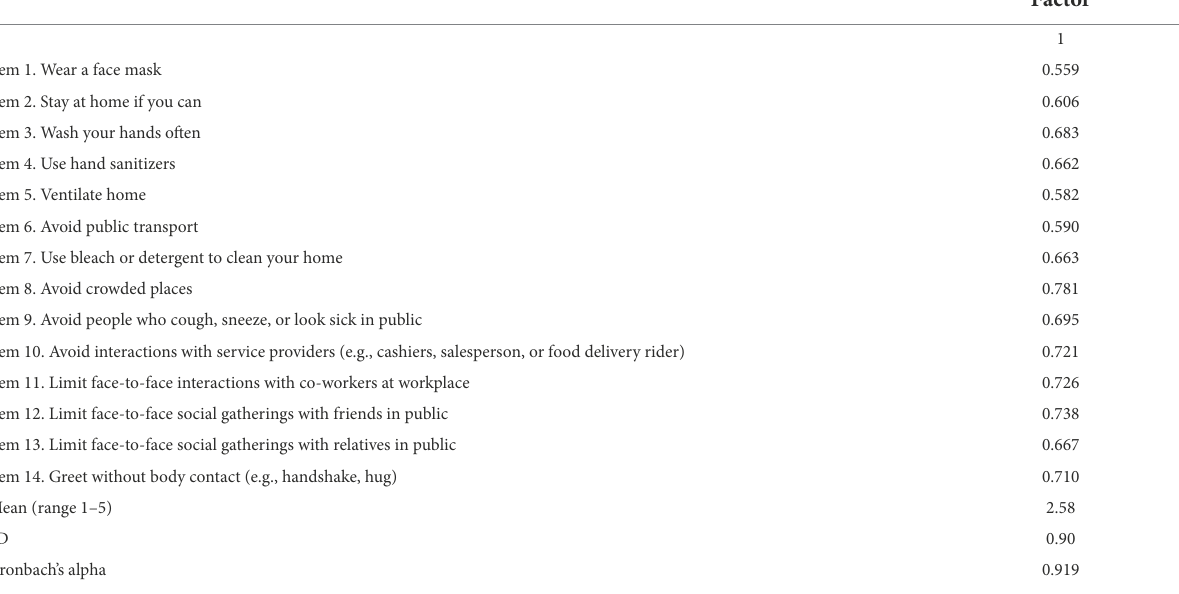
TABLE 3 Factor loadings of the observed variables (factor matrix), descriptive statistics, and reliability of the extracted factor ( N = 1955).